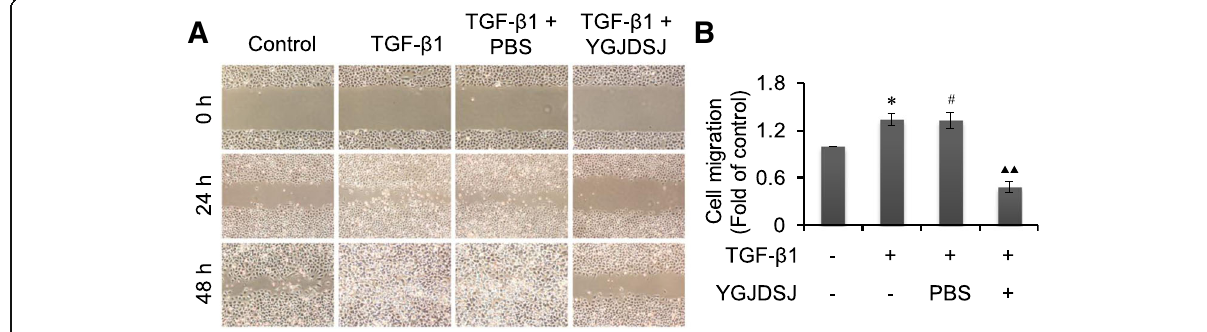
Fig. 6 Effects of YGJDSJ on TGF- β 1-induced cell migration. a , Bel-7402 cells were scratched by a sterile pipette tip and treated with TGF- β 1 and YGJDSJ or PBS for 48 h, cell migration was observed under a microscope (× 40). b , Cell migration distance at 24 h were measured by electronic ruler and expressed as fold of control. * p < 0.01, versus control group; # p > 0.05, versus TGF- β 1 group; ▲▲ p < 0.01, versus PBS